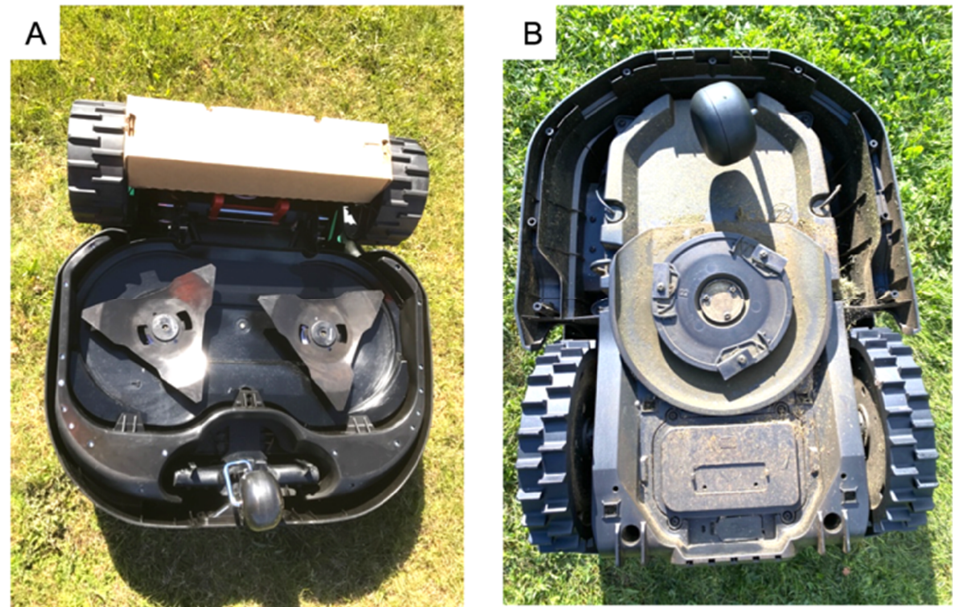
Figure 1. Fixed or pivoting blades. ( A ) A robotic lawn mower with fixed blades. ( B ) A robotic lawn mower with pivoting blades. Pivoting blades will fold into a protective frame when hitting something harder than grass, as opposed to fixed blades, which are constantly exposed. Photographs by Petrus Ekbladh and Ronja Mathiesen.